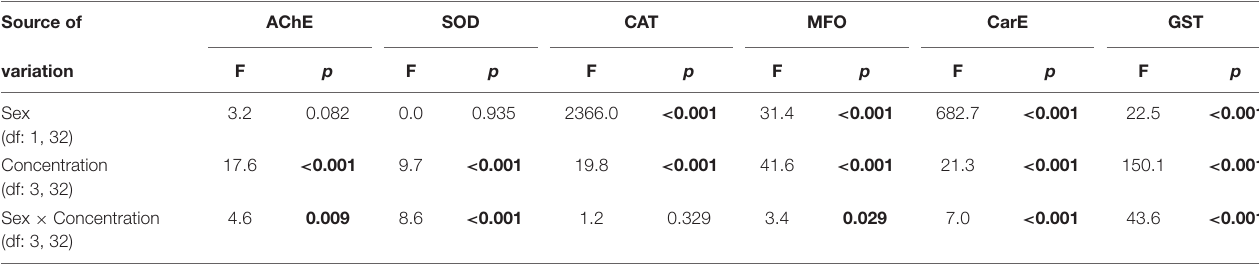
TABLE 4 | F and p values from 2-way ANOVA testing significance of main and interaction effects of sex and thymol concentration on activities of acetylcholinesterase (AChE), superoxide dismutase (SOD), catalase (CAT), mixed-function oxidase (MFO), carboxylesterase (CarE), and glutathione S-transferase (GST) in Acanthoscelides obtectus